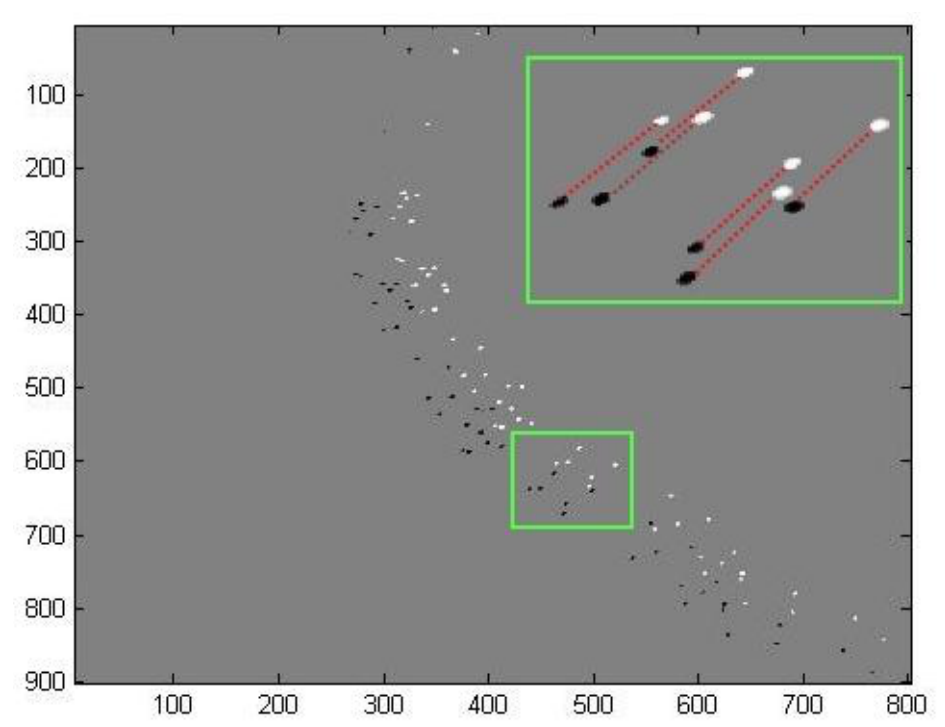
Figure 4. Illustration of matching particles in time. The estimated local displacements for some fertilizer particles are illustrated by red lines. For clarity, both images were